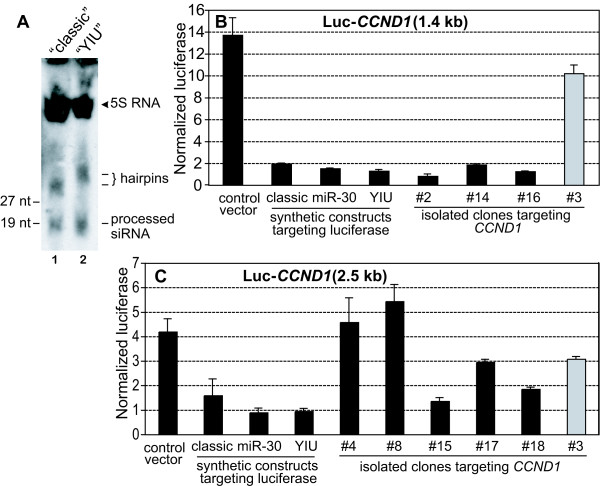
A. Total RNA isolated from HEK293T cells transfected with either a "classic" or "YIU" construct targeting luciferase was analyzed by Northern blot hybridization to a radioactively labeled luciferase 19-nt sense-strand oligonucleotide and to a 19-nt oligonucleotide complementary to 5S RNA. 19- and 27-nt single-stranded DNA oligonucleotides were used as size standards; because DNA rather than RNA oligonucleotides were used, the indicated sizes are only approximate. The expected approximate sizes of the hairpin transcripts are 49 nt ("classic") and 62 nt ("YIU"), whereas both processed forms are expected to be ~21 nt. B. and C. Constructs expressing luciferase mRNA fused with a fragment of CCND1 mRNA were cotransfected with shRNA expression constructs targeting either luciferase or CCND1, as described in Table 1. The negative control shRNA expression construct was a "classic" construct targeting BCL2. Samples were analyzed in duplicate, and values were normalized using Renilla luciferase expression. Error bars represent the standard deviation. The shRNA constructs targeting CCND1 was cotransfected with a luciferase-CCND1 fusion construct containing the target sequence, with the exception of #3, whose target sequence is absent from both fusion constructs. Construct #3 thus serves as an additional negative control. The small degree of suppression seen with #3 and the apparent small stimulation by some shRNA cassettes may be either due to experimental error or to off-target effects of #3 and of the control shRNA construct. The data shown are representative of three individual experiments, which all showed similar results.